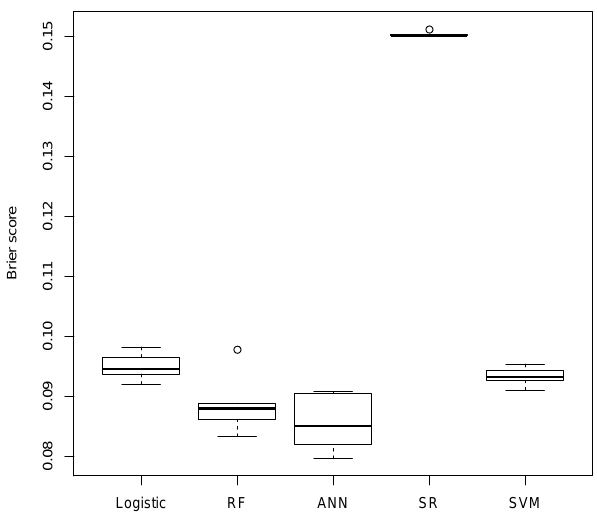
Figure 9. Comparison of the Brier scores of the five machine learning models for